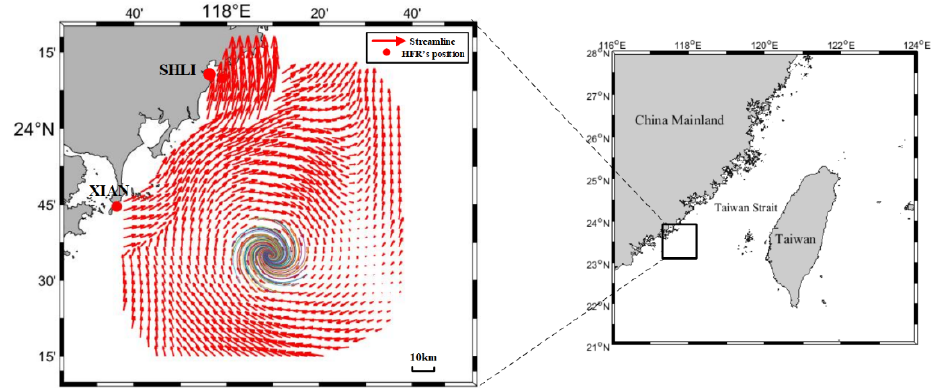
Figure 1. The observed region in Taiwan Strait.